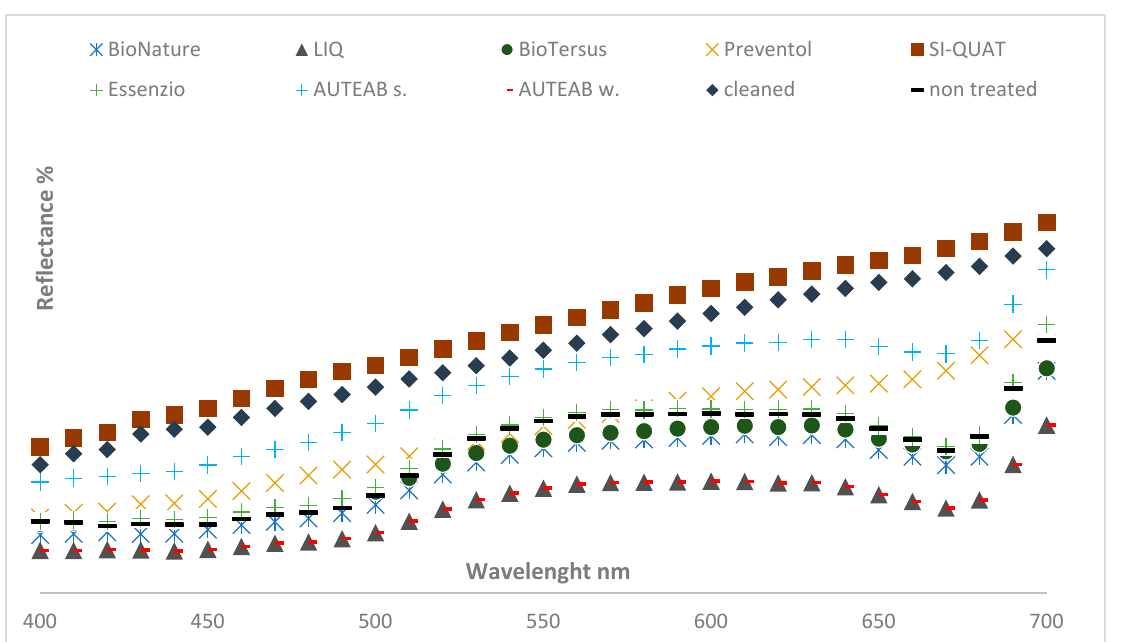
Figure 3 . Full spectrum color measurement of the treated zones in Area 1. Standard deviation 0.5 < SD < 3.2.